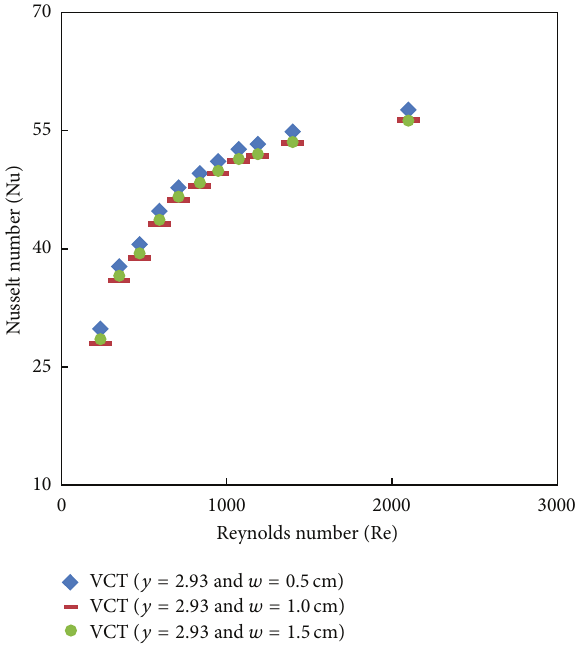
Figure 9: Simulated friction factor of V-cut twisted tape with different twist ratios ( 𝑦 ) and different cut depths.